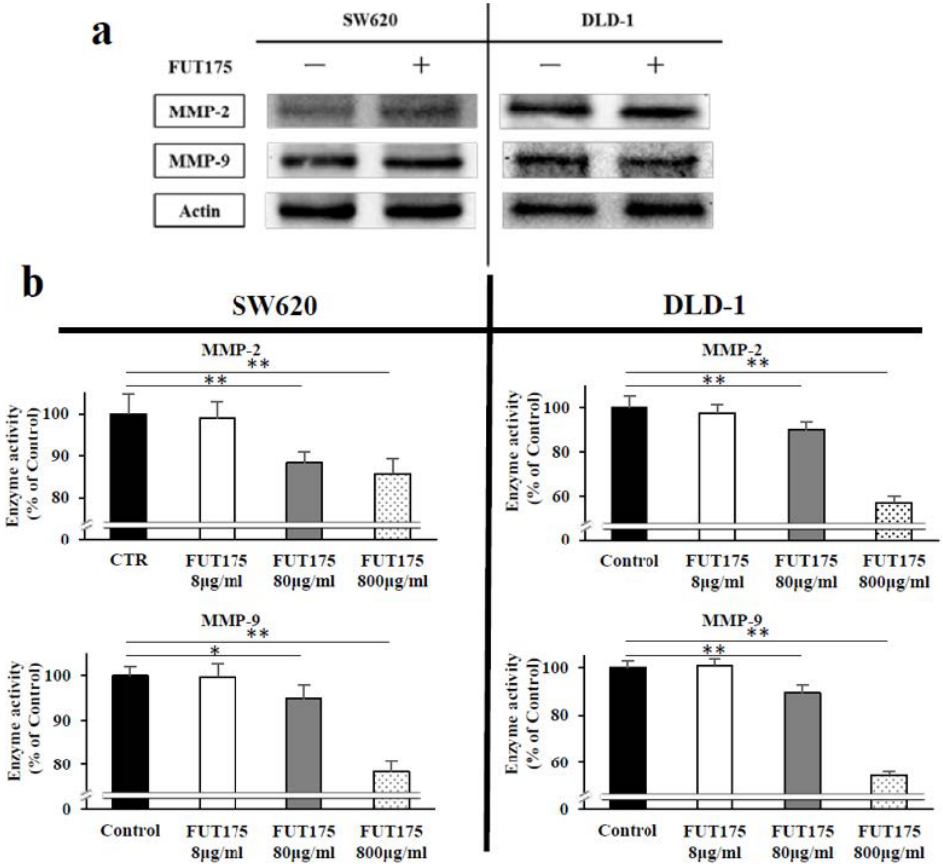
Figure 7. Nafamostat mesilate (FUT175) directly inhibits the activity of matrix metalloproteinase (MMP)-2 and MMP-9. ( a ) The cells were treated with FUT175 (80 µ g/mL) for 3 h prior to irradiation (5 Gy). At 24 h of incubation after the treatment, the proteins of MMP-2 and MMP-9 were measured by western blot analysis. FUT175 did not significantly alter the protein expression of MMP-2 and MMP-9. ( b ) The enzymatic activity of MMP-2 and MMP-9 was measured immediately after FUT175 treatment (control, or 8, 80, 800 µ g/mL) by quantitative MMP activity assay. The activity of MMP-2 and MMP-9 was significantly and dose-dependently inhibited by FUT175. *, p < 0.05; **, p < 0.01. All experiments were performed in triplicate.